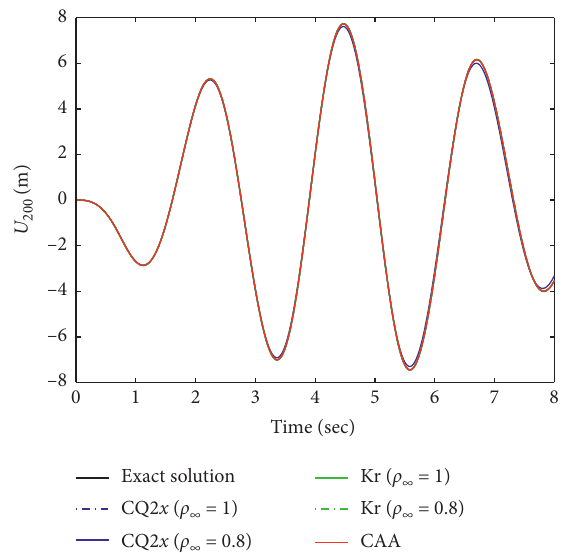
Figure 33: Displacement responses of the 200th DOF when n �